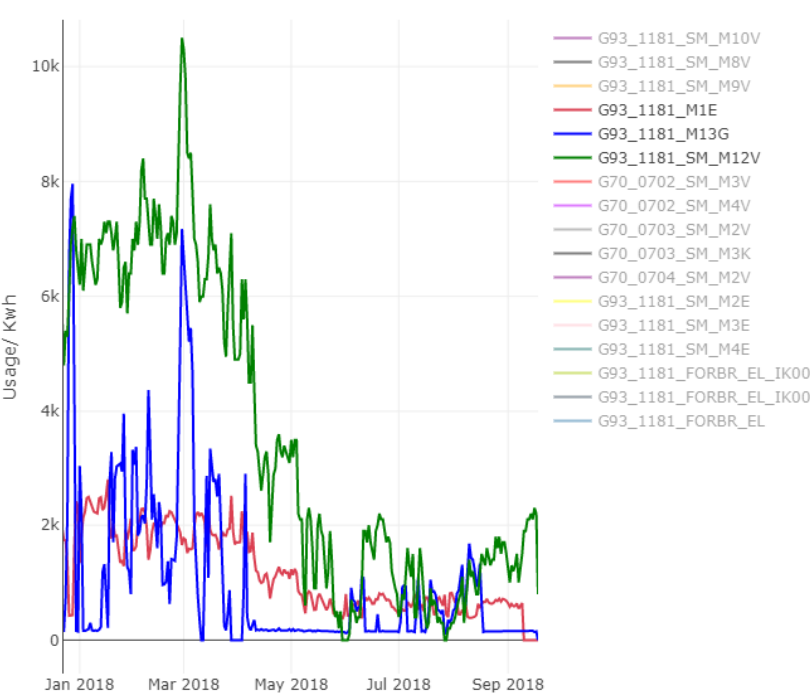
Figure 13. Monthly energy usage of the selected devices.